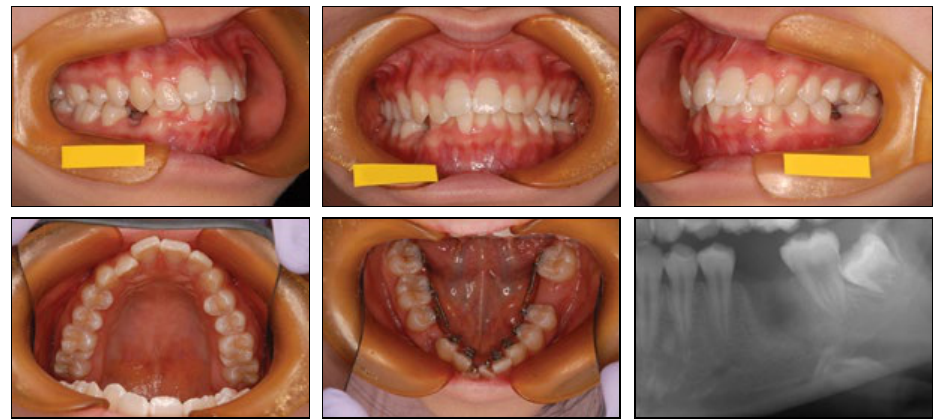
Figure 6. Initial phase of treatment progress. Extracted spaces of the mandible were beginning to close by closed coil spring applying extra light force. The panoramic radiograph after enucleation of the cyst.